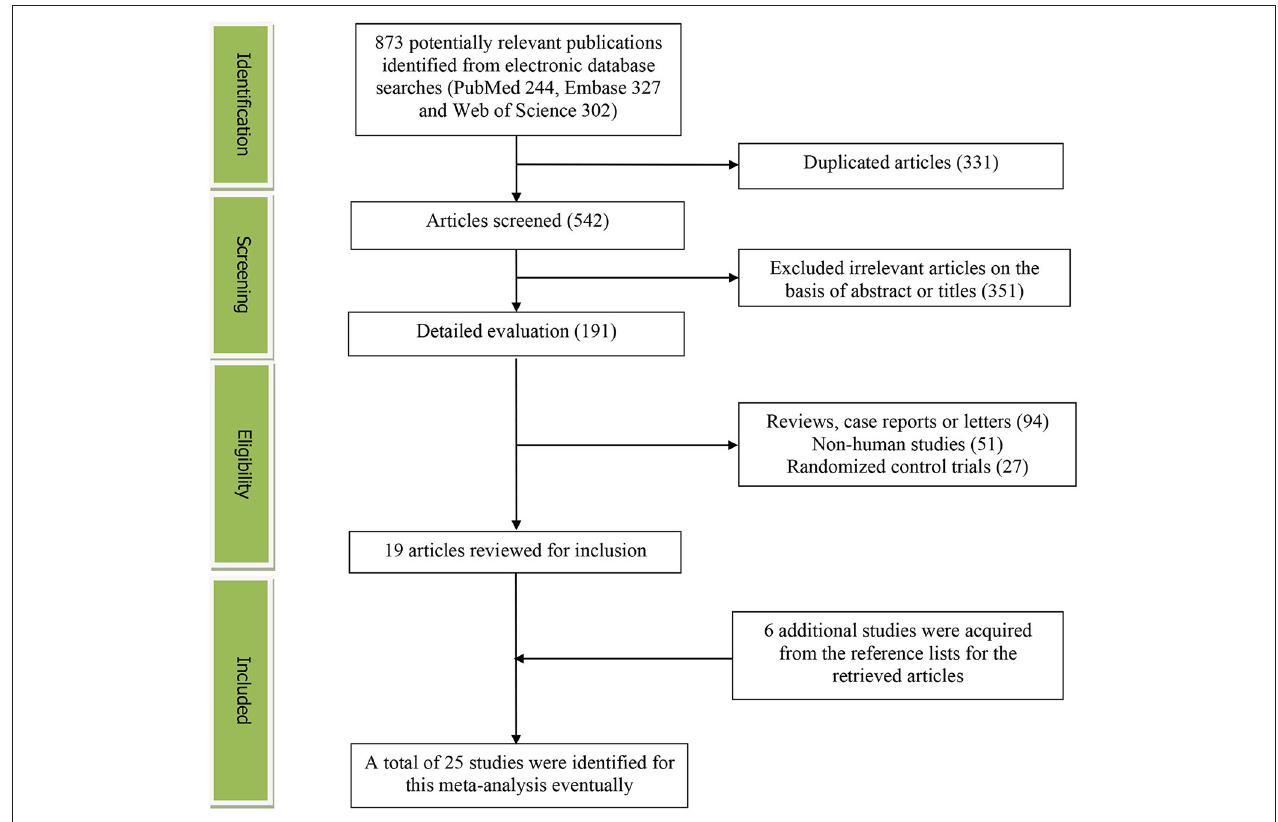
FIGURE 1 | The detailed flow diagram of the study identification and selection in this